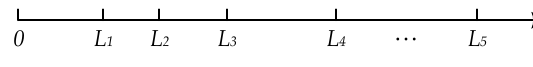
l L , i l L , i C i